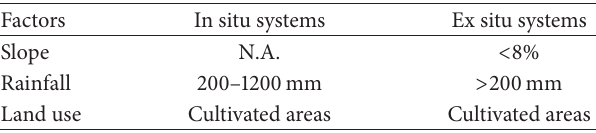
considered as less convenient for ex situ water harvesting activities [40, 62].